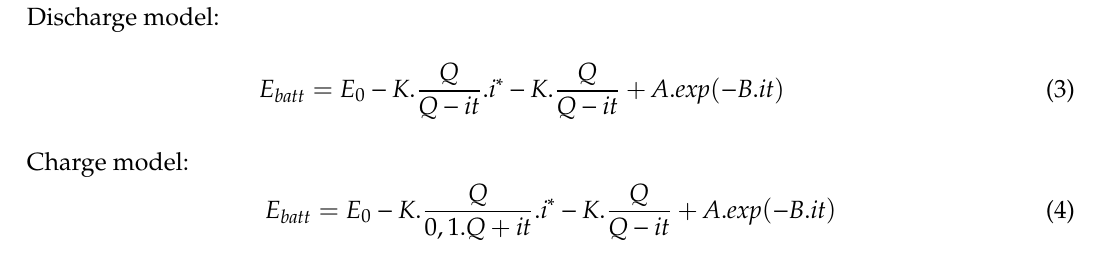
Table 5. LiFePo4 simulated characteristics.